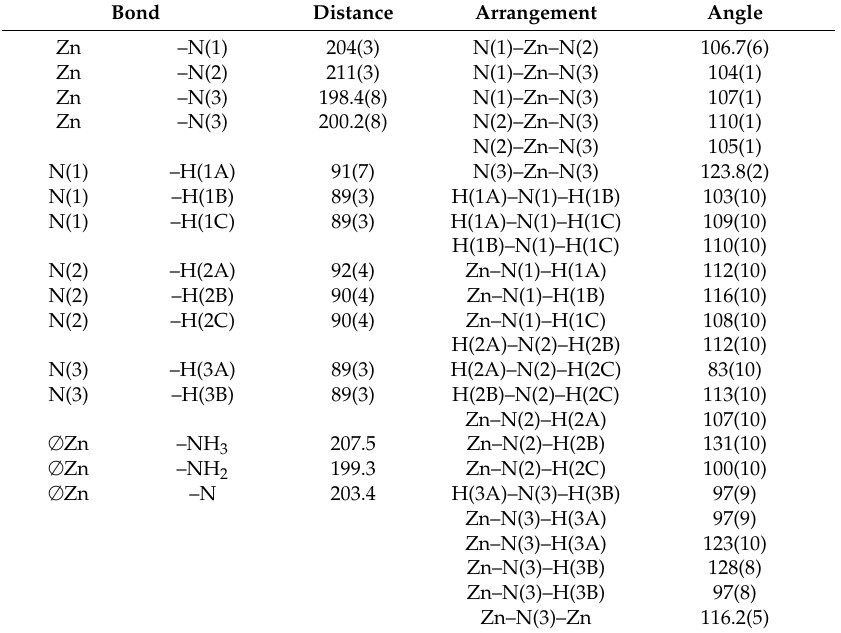
Selected interatomic distances (pm) and angles (deg.) in the crystal structure of